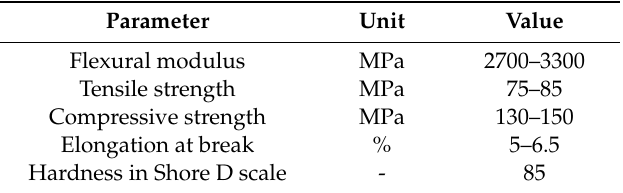
Table 2. Properties of epoxy resin LG285 with HG285 curing agent.